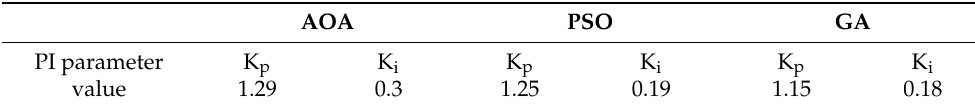
Table 10. Optimized PI parameters for L-G scenario. AOA PSO GA PI parameter K p